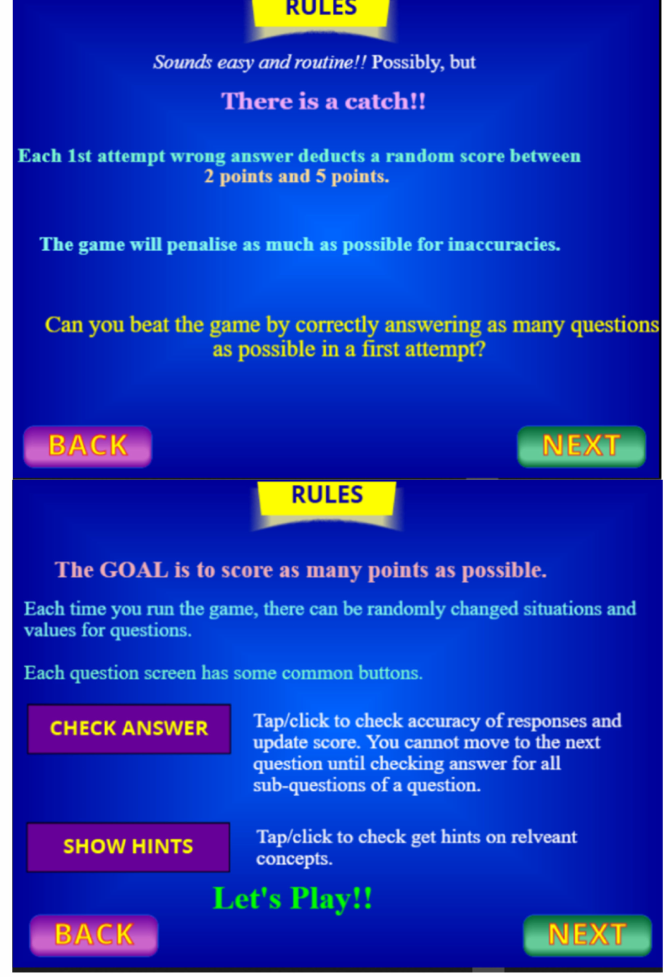
Figure 3. Game rules